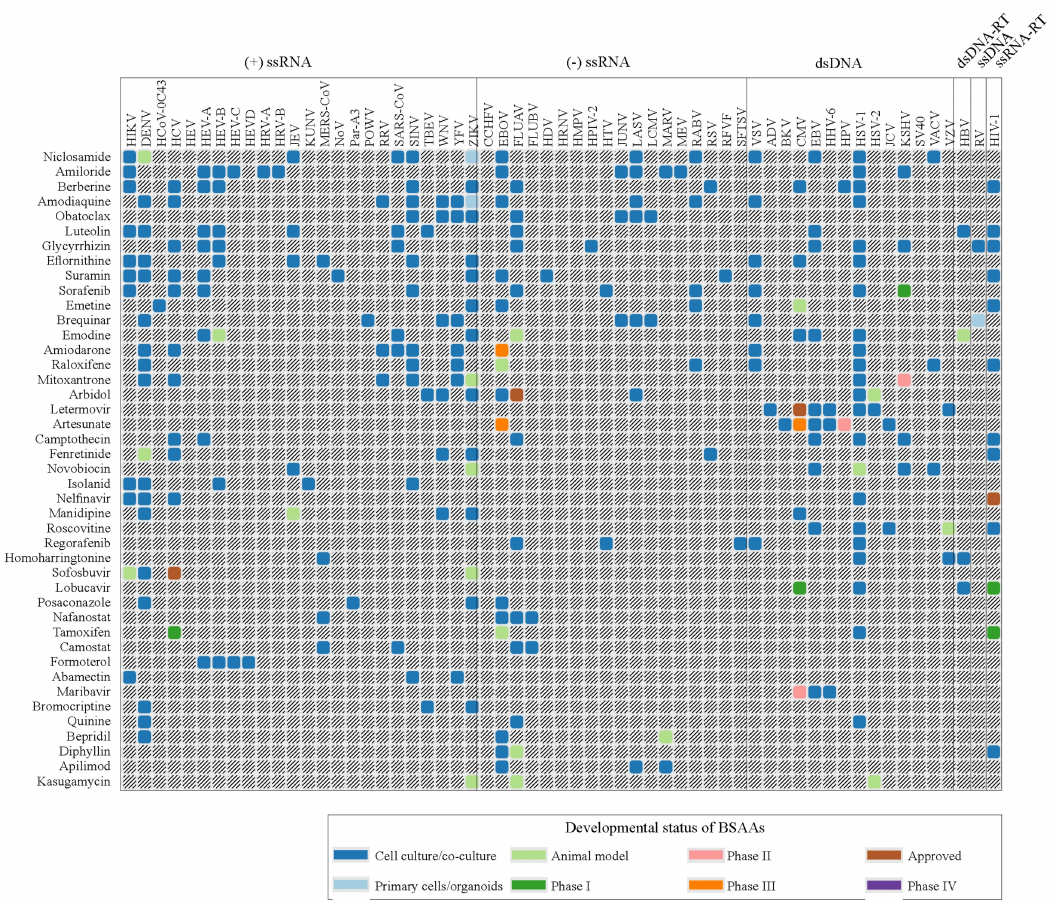
Figure 1. Forty-three safe-in-man broad-spectrum antiviral agents (BSAAs) and viruses that they inhibit. Viruses are clustered by virus groups. BSAAs are ranged from the highest to lowest number of targeted viruses. Di ff erent shadings indicate the di ff erent development status of BSAAs. Gray shading indicates that the antiviral activity has not been either studied or reported. Abbreviations: ds, double-stranded; RT, reverse transcriptase; ss,